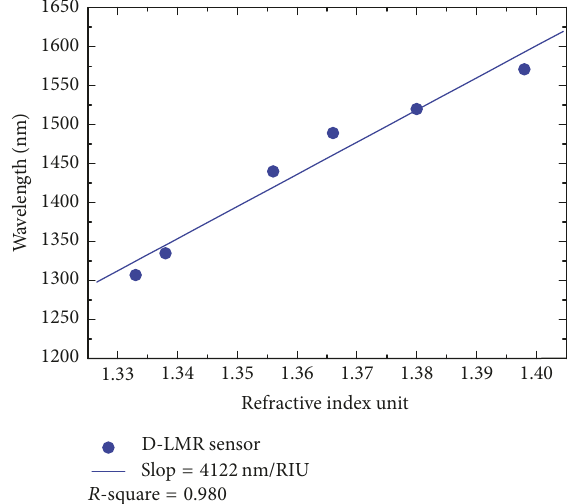
Figure 6: LMR wavelength as a function of the refractive index for different NaCl